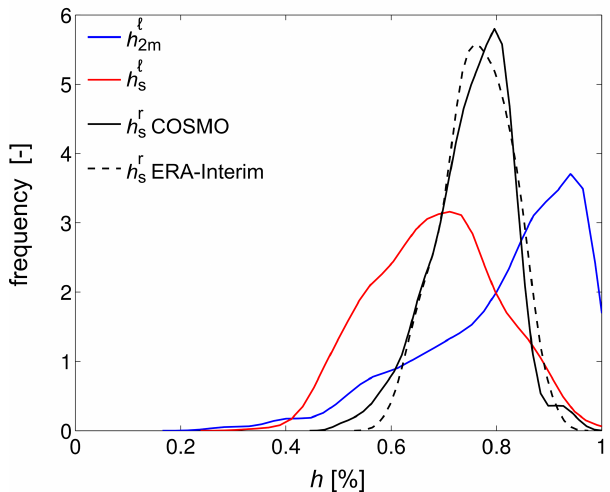
Fig. 4. Distributions of h ‘ measurements at the Rietholzbach site 2m with respect to 2m temperature in blue, h ‘ s measurements with re- spect to soil temperature 5cm below ground in red. The distribu- tion of diagnosed moisture source h r s using COSMO analyses is shown by the black solid line, the diagnosed moisture source h r s us- ing ERA-Interim data is shown by the black dashed line. All the distributions are shown for the complete data set from August to December